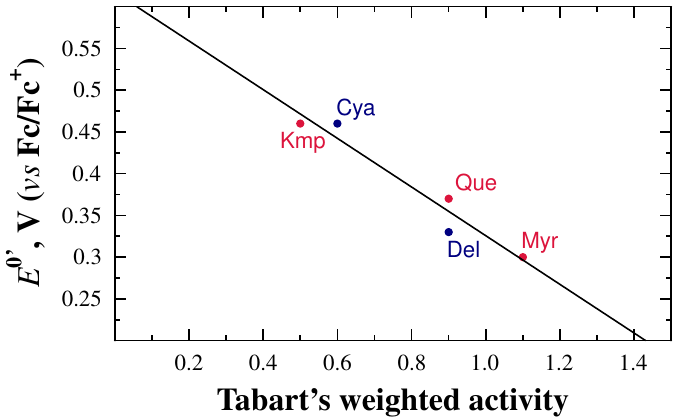
Figure 6. Correlation between formal reduction potentials, E (cid:48) average